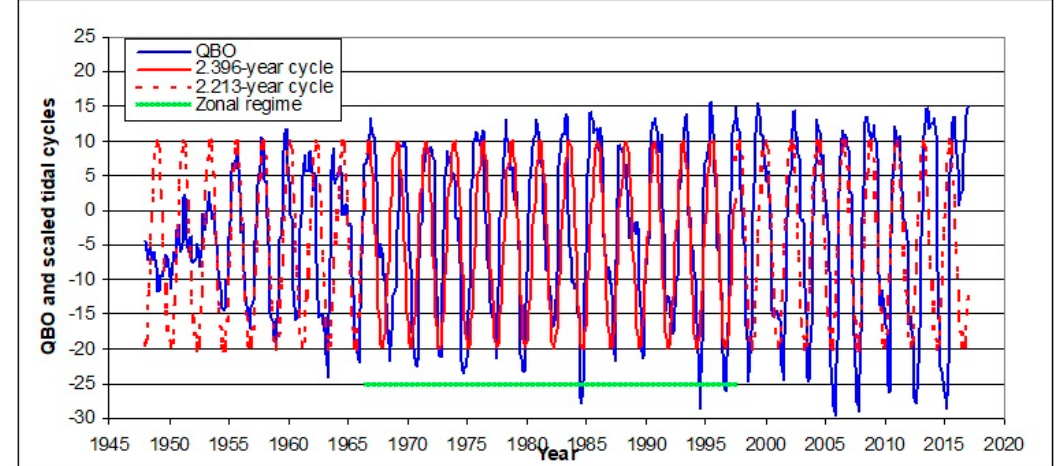
Figure 9. Comparison of the monthly QBO dataset with the vertically scaled 2.123- and 2.396-year tidal oscillations, with a QBO lag time of 0.15 years.